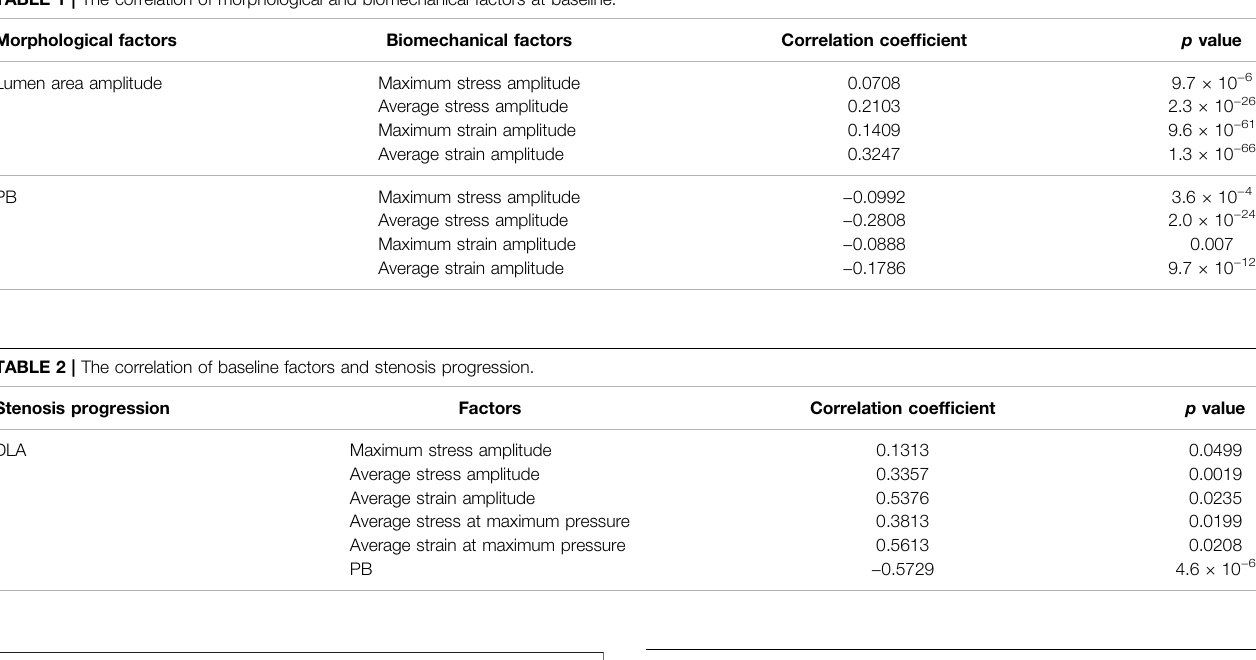
TABLE 3 | The value of mean decrease in Gini index for top eight factors.